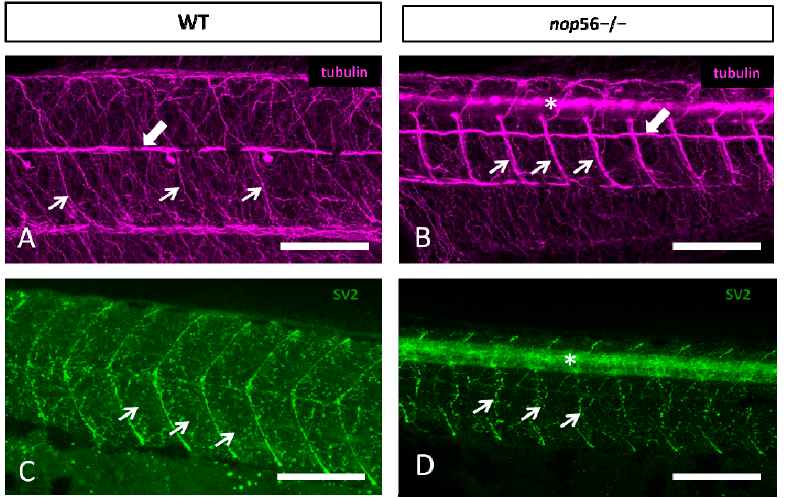
Figure 6. ( A , B ) Lateral views of WT ( A ) and nop56 − / − ( B ) 3.5 dpf larvae showing malformations in the neuromuscular junctions and the innervation of the trunk myomeres. All images are projections from confocal z-stacks. ( A , B ) Alpha-tubulin staining (magenta) showing alterations in the distri- bution of fibers and bundles in the trunk (thin arrows). White thick arrows in ( A , B ) point to poste- rior lateral line nerve. ( C , D ) SV2 (green) staining showing alterations in neuromuscular junction (arrows) and myosepta in nop56 − / − compared to wild type. Asterisk in ( B , D ) marks the spinal cord. Scale bar: 150 μ m.